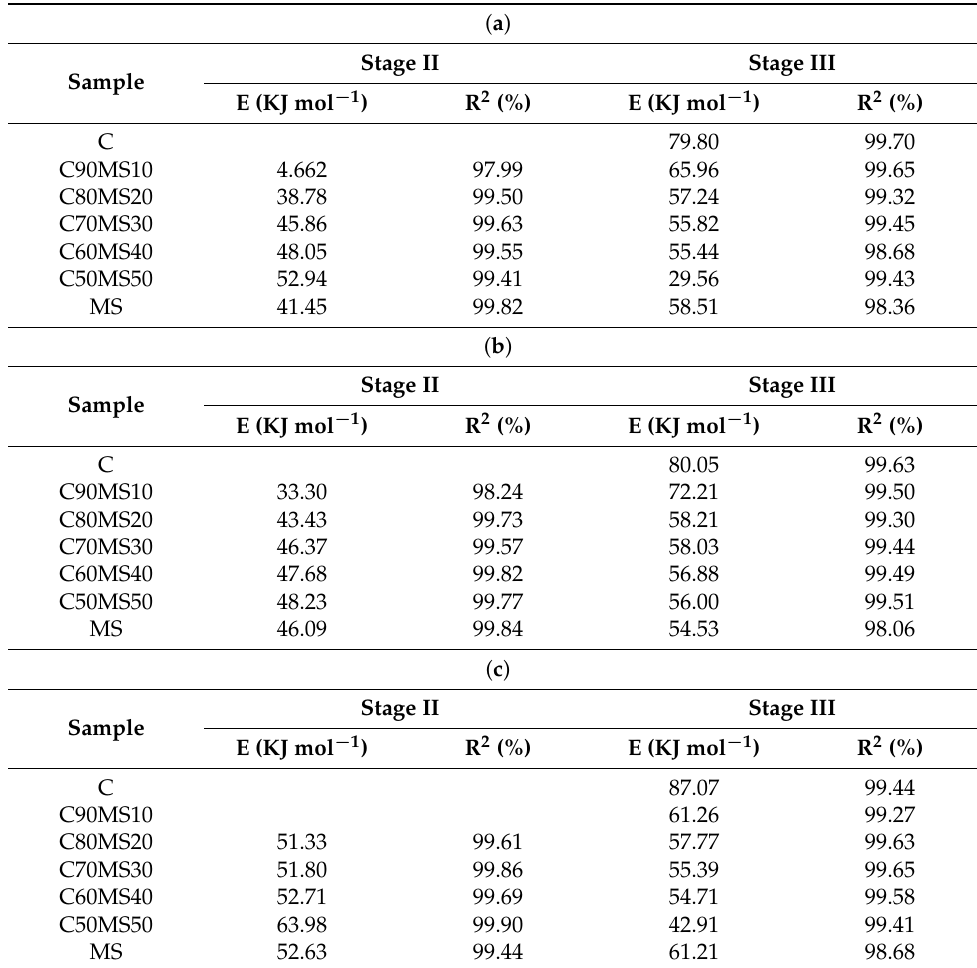
Table 2. Kinetic properties of coal, municipal sludge and their blends at heating rates of 10 ( a ), 20 ( b ) and 60 ( c ) ◦